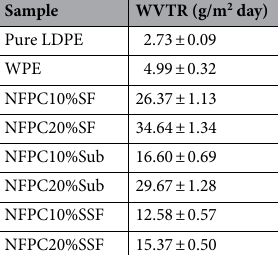
Table 3. WVTR of pure LDPE, WPE as well as the prepared NFPCs containing different concentration of unmodified (SF) and modified (Sub and SSF) sunflower fibers.